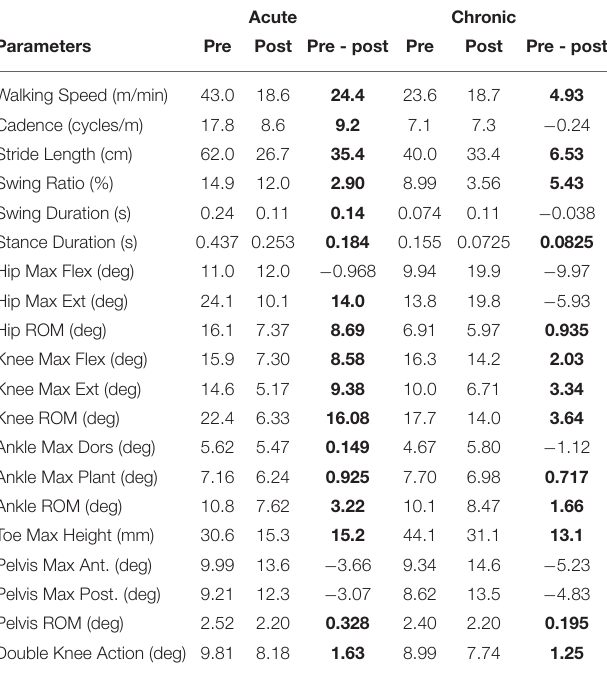
TABLE 6 | RMS (root mean squared) difference of gait kinematics of acute and chronic stage patients, pre and post intervention, compared to healthy subjects, and its changes between pre and